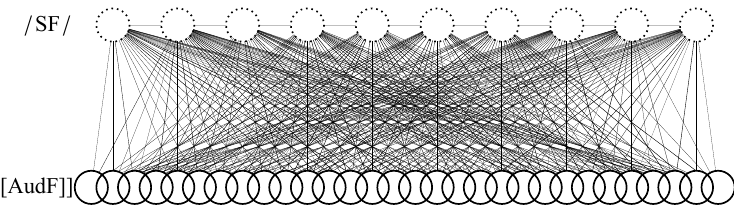
Figure 12: The initial state of a network for category creation, with continu- ous sound coming in at clamped AudF and discrete behaviour emerging at un- clamped SF